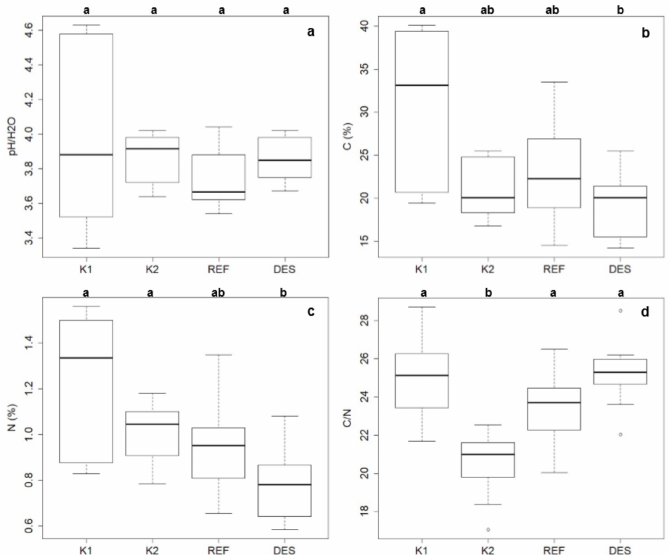
Figure 6. Soil ( a ) pH/H 2 O, ( b ) carbon concentration (C%), ( c ) nitrogen concentration (N%), ( d ) C/N ratio detected in forest that is attacked by bark beetle (K1), destroyed by bark beetle (K2), with removed trees (DES), and mature (REF). The diagrams represent median, quartiles, and range (1.5 * IQR) from 10